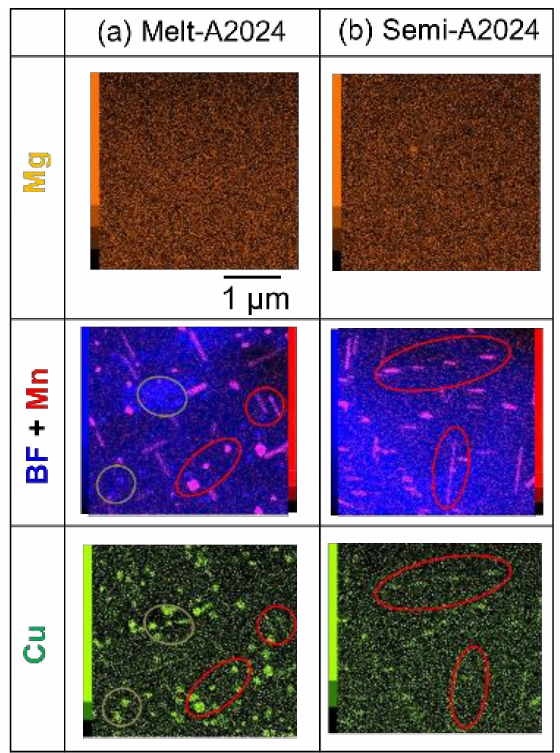
Figure 15. X-ray mapping images by TEM-EDS: ( a ) Melt-A2024; ( b ) Semi-A2024.